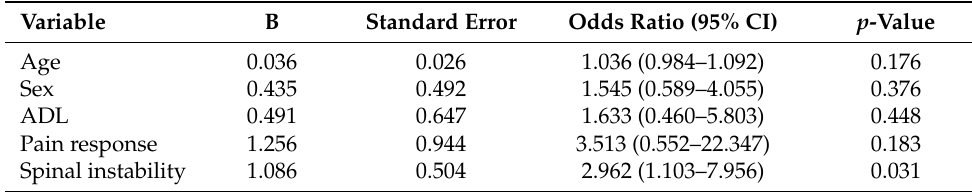
Table 4. Factors affecting global health status.